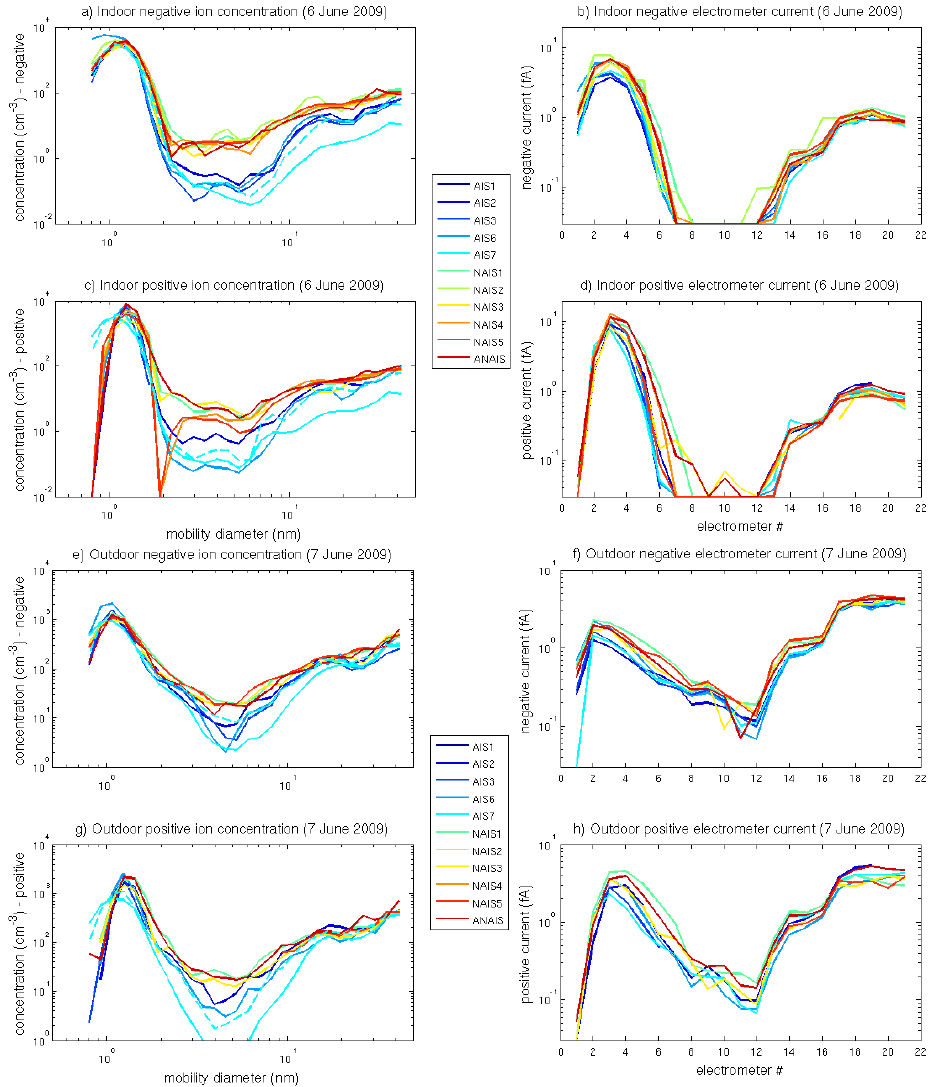
Fig. 6. Median concentration size distribution and electrometer current size distribution for indoor air (negative: (a) , (b) ; positive: (c) , (d) , measured on 6 June 2009 and for outdoor air (negative: (e) , (f) ; positive: (g) , (h) , measured on 7 June 2009. The AIS7 re-inverted concentrations are represented by the dashed line of the same color.